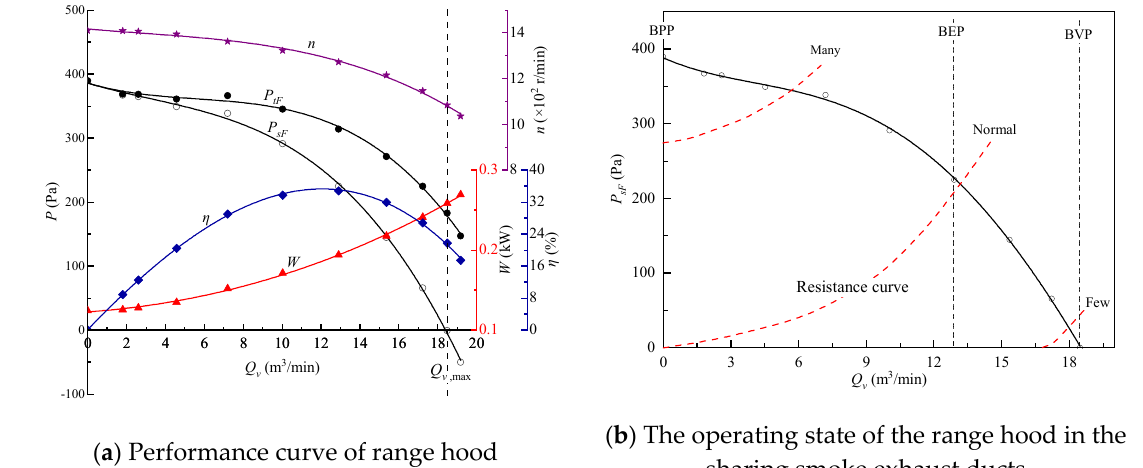
Figure 5. Operating status of range hood.